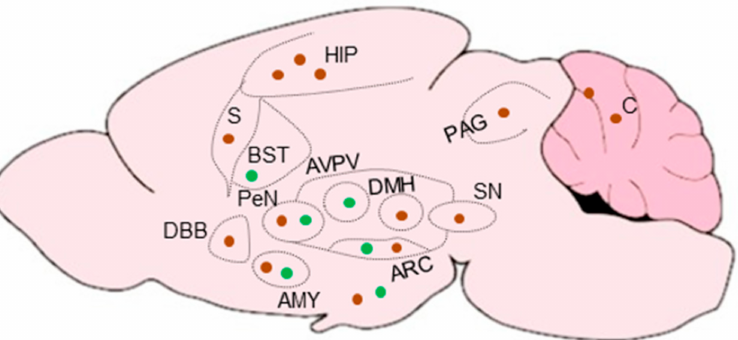
Figure 8. Hypothalamic and extrahypothalamic expression of kisspeptins and kisspeptin receptor in the brain. Anatomical distribution of kisspeptin (KP) mRNA (green dots) and KP receptor (KPR) mRNA (brown dots) in different brain areas of rodents. KP mRNA expression is mostly detected in the hypothalamus (ARC, AVPV, and PeN). Presence of KP mRNAs has also been reported in the amygdala (AMY) and bed nucleus of stria terminalis (BST). KPR mRNA has been detected in